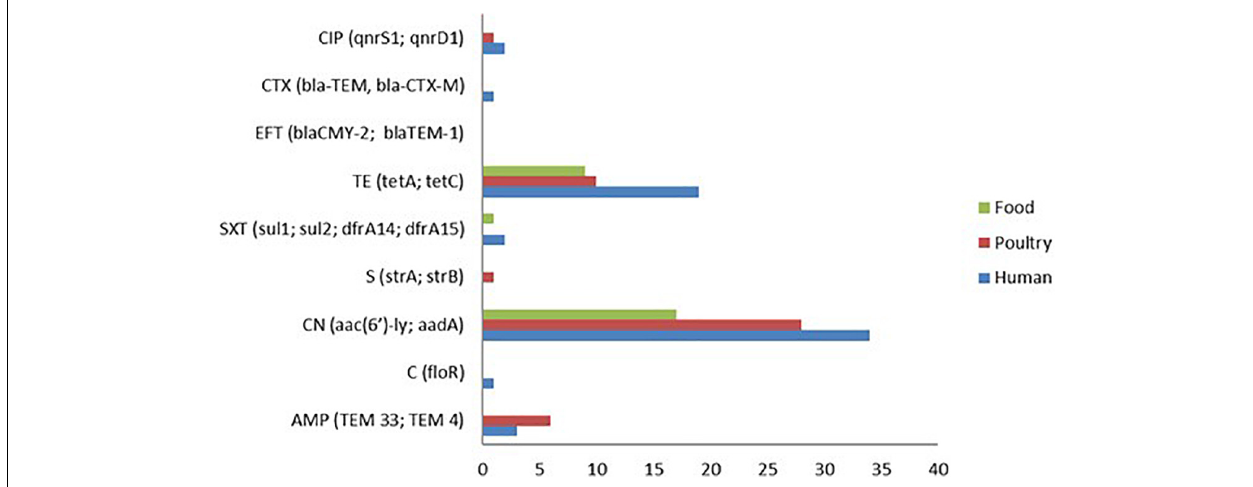
FIGURE 2 | Genotypic antimicrobial resistance (AMR) patterns of S. Enteritidis isolates showing aminoglycoside resistance genes ( aac (6 (cid:48) )-ly ) and aadA as the predominant resistance genes detected followed by tetracycline ( tetA and tetC ) genes. TABLE 3 | Correlation between AMR phenotype by Kirby Bauer method and genotypic AMR WGS analysis for S. Enteritidis isolates ( n = 82). Antimicrobials Resistant isolates Susceptible isolates Sensitivity (%) Specificity (%) PPV (%) NPV (%) Genotypic Phenotypic Genotypic